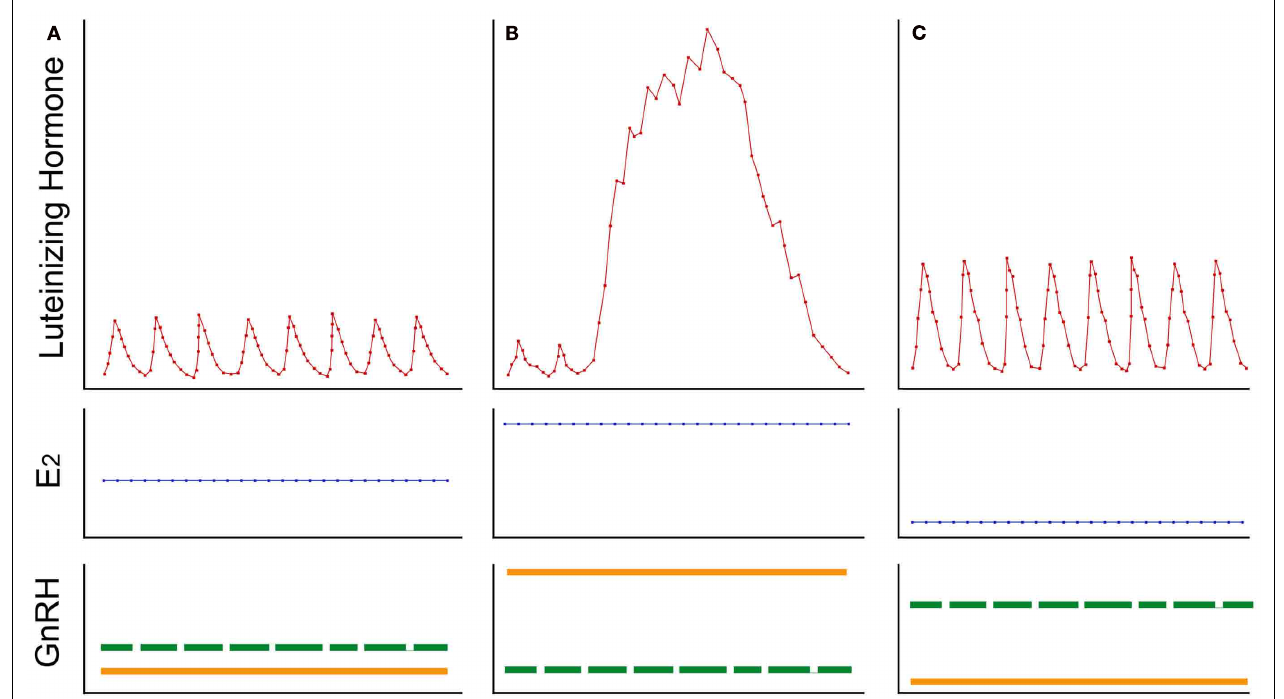
but markedly stimulate synthesis and release of GnRH-II. (C) High amplitude pulses of LH are typically observed after ovariectomy and after menopause, as a result of the highly attenuated plasma E 2 levels; in the absence of significant E 2 negative feedback, GnRH-I neurons show increased activity whereas GnRH-II neurons lack positive feedback and so revert to a relatively quiescent state. Although it is commonly assumed that the same GnRH neurons can mediate both negative and positive E 2 feedback onto LH release, the data presented in this mini-review question this assumption. Instead, it is hypothesized that tonic and surge modes of LH release are orchestrated by two distinct GnRH neuronal populations, which in primates can be distinguished by their capacity to produce different molecular forms of GnRH (i.e., GnRH-I and GnRH-II, respectively) and to respond differentially to E 2